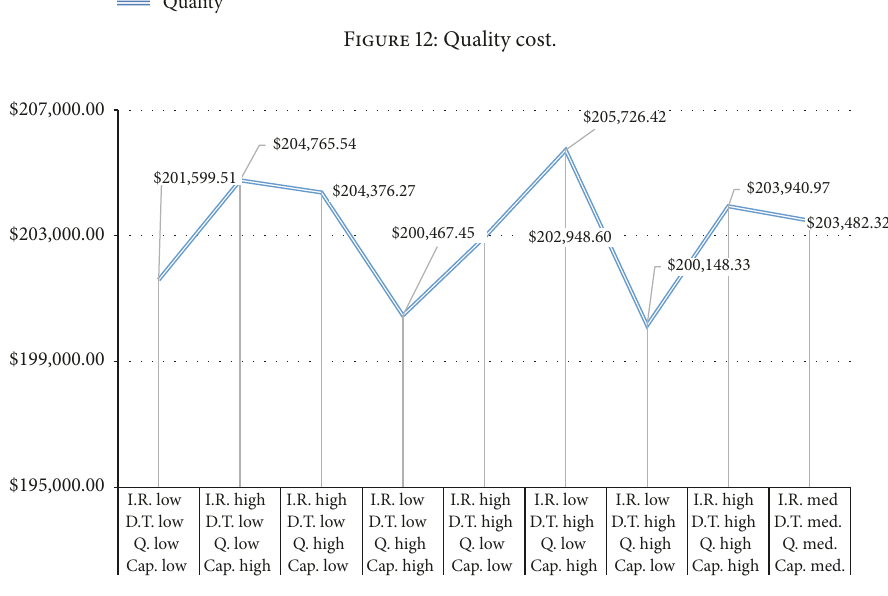
Figure 12: Quality cost.